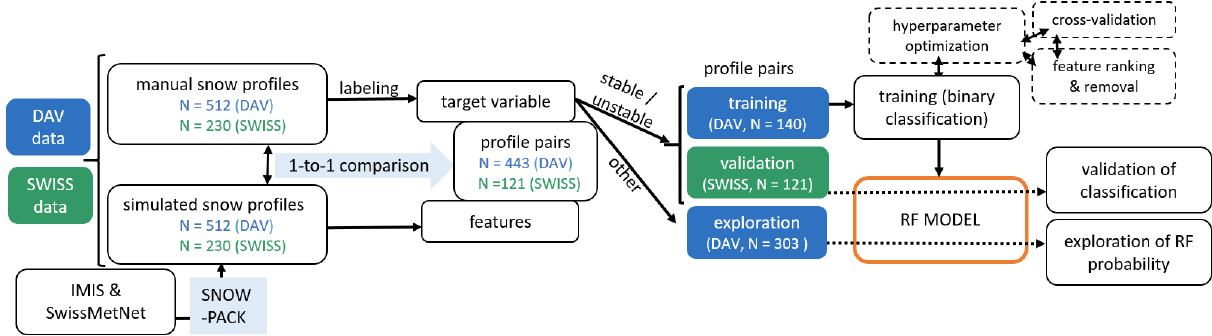
Figure 1. Overview of data sets and steps used for data pre-processing (left side) and model training and evaluation (right side).